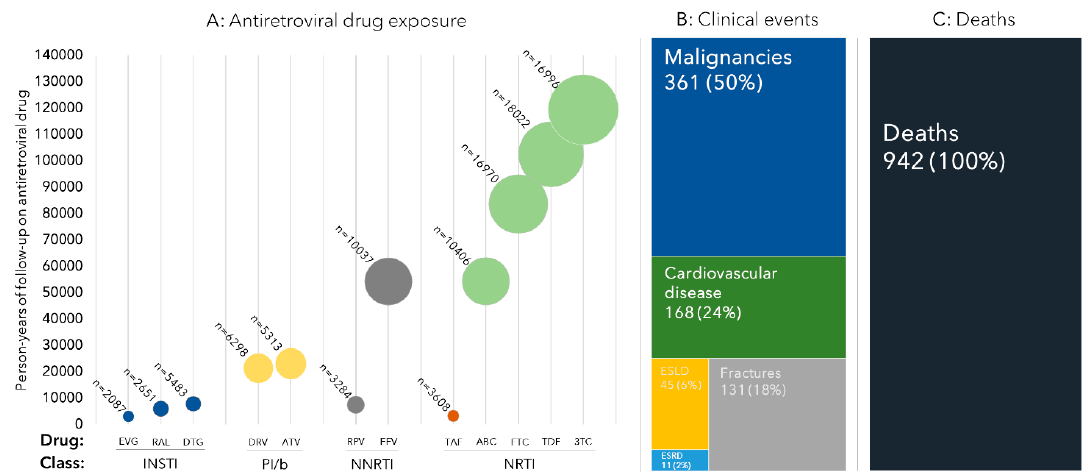
Figure 3. A : Antiretroviral exposures at RESPOND enrolment; B : number of validated clinical; C : number of deaths in the study period events, after the 1st RESPOND data